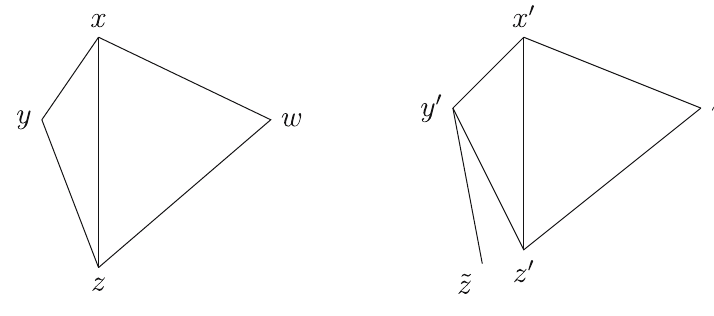
Figure 3: Proof of Lemma